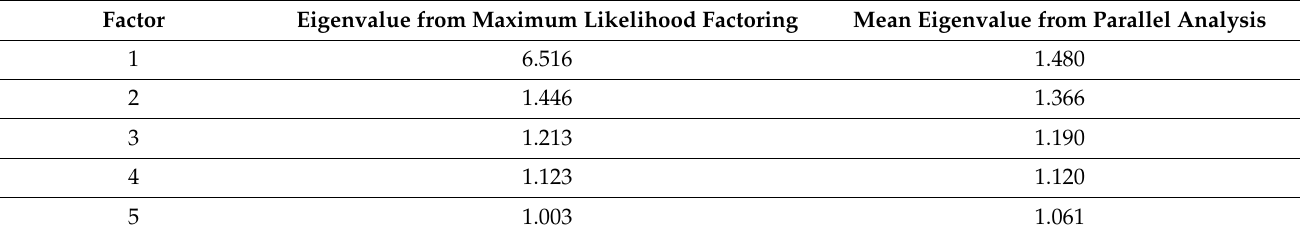
Table 3. Factor extraction in the exploratory factor analysis by comparing the Eigenvalue of factors from the maximum likelihood estimation and parallel analysis.